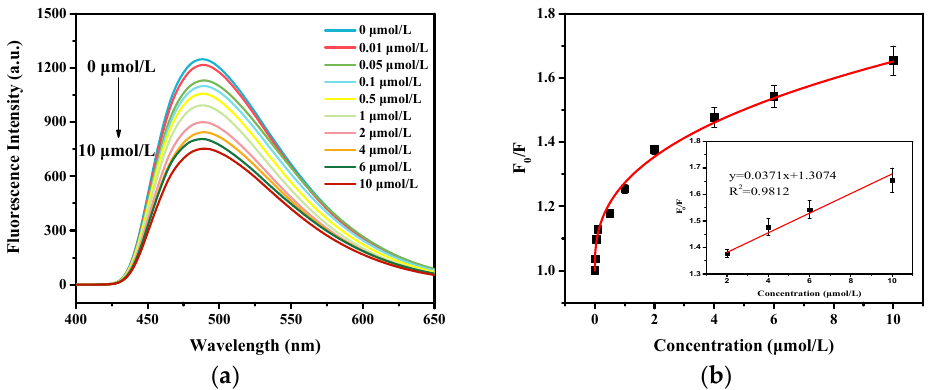
Figure 8. Fluorescence spectra of the fluorescence sensor in the presence of different concentrations of NO 2− ( a ) and the plot of F 0 /F versus NO 2− concentration ( b ).